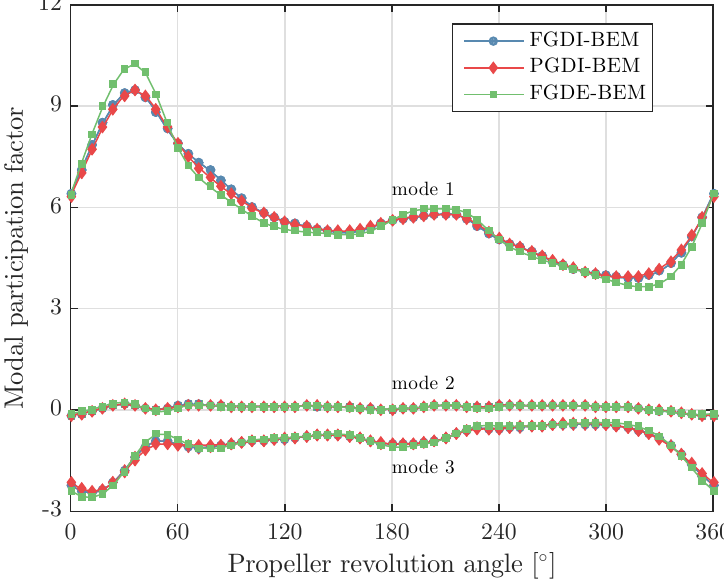
Figure 14. Modal participation factors for the first three modes computed with different BEM-FEM couplings for the glass–epoxy Seiun–Maru propeller.